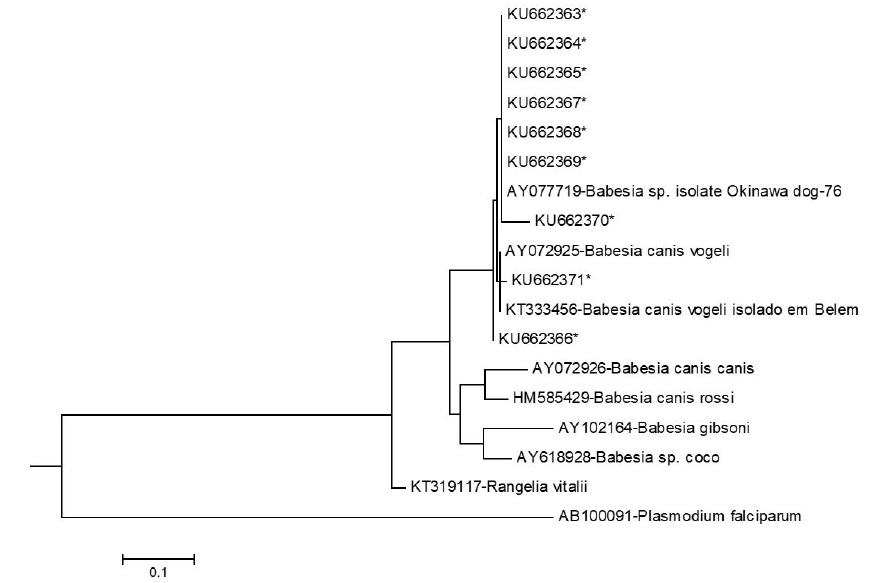
Figure 1. Phylogeny dendogram assessed in the molecular detection study of dogs naturally infected by Babesia vogeli in the metropolitan region of Rio de Janeiro. The sequences obtained by Genbank are preceded by their access numbers. The sequences marked with (*) are samples obtained in this study, which were positive for B. vogeli by PCR and sequencing. These sequences were identified with their GenBank accession